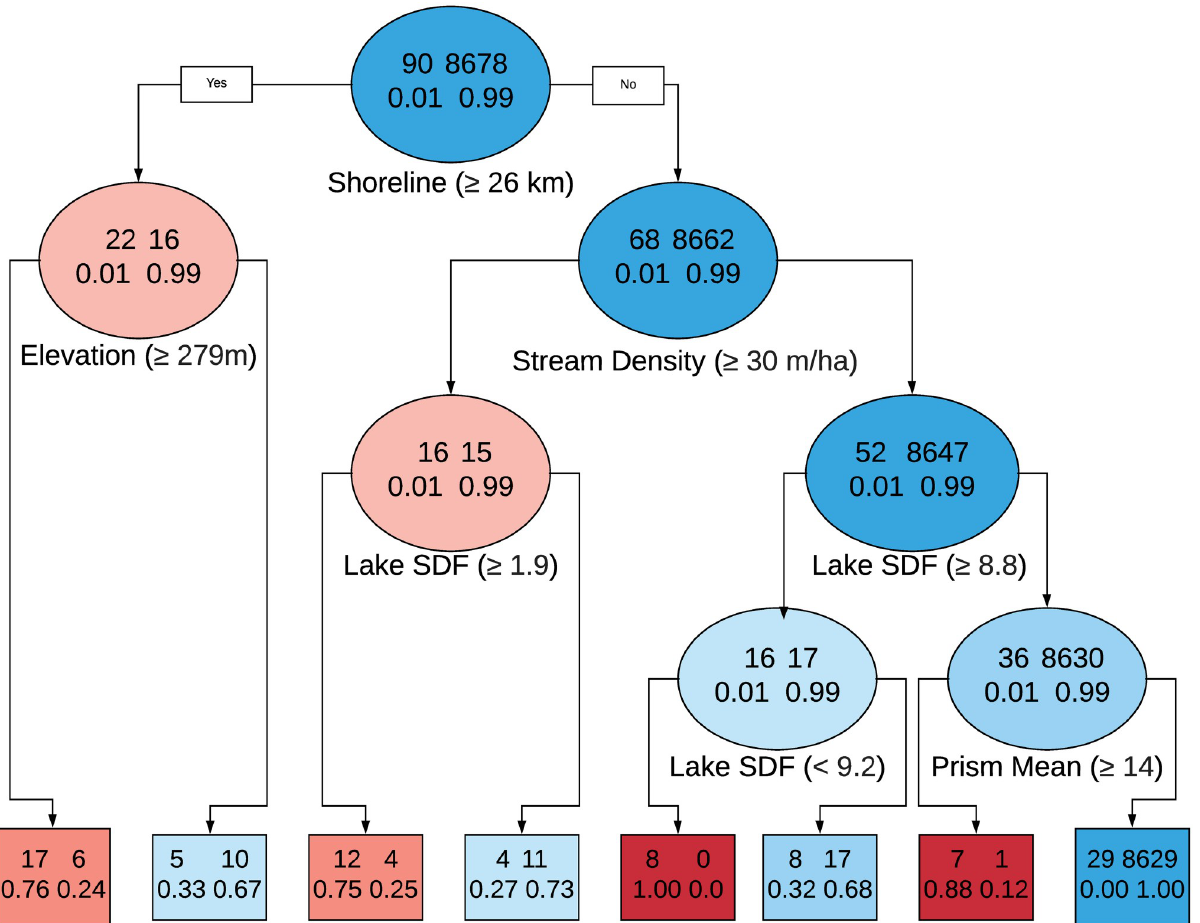
Fig 4. CART model results showing which variables may be useful in identifying extrapolations for inland lake. Each level of nodes include the thresholds and variables used to sort the data. Node color indicate whether the majority of sorted inland lake locations were identified as predictions (blue) or extrapolations (red). The first row of numbers in a node indicate the number of lakes identified as predictions (right) or extrapolations (left) that have been sorted into this node. The second row of numbers indicate the percentage of lakes that are identified as predictions (left) or extrapolation (right) with the terminal nodes (square nodes) including the percentage of records sorted by the decision